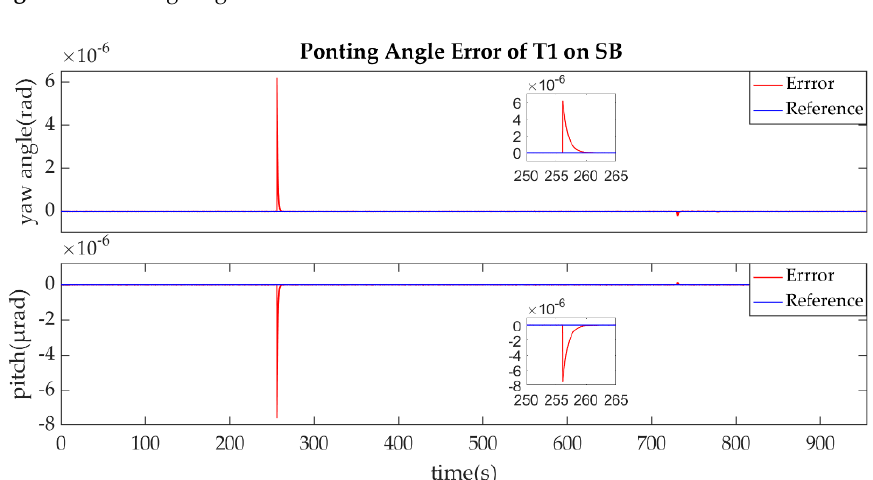
Figure 18. Ponting Angle Error of T1 on SB.